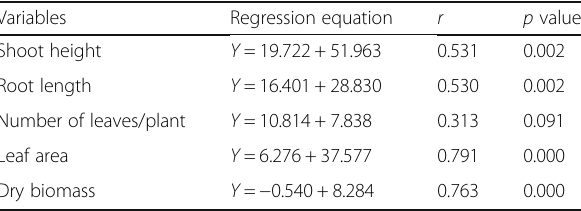
Table 5 Seed weight influence on seedling characteristics in E. prunifolius . Regression Eq. ( Y = c + mx ) for the relationship between initial seed weight ( n = 10), shoot and root length (cm), number of leaves/plant, leaf area (cm 2 ) and dry